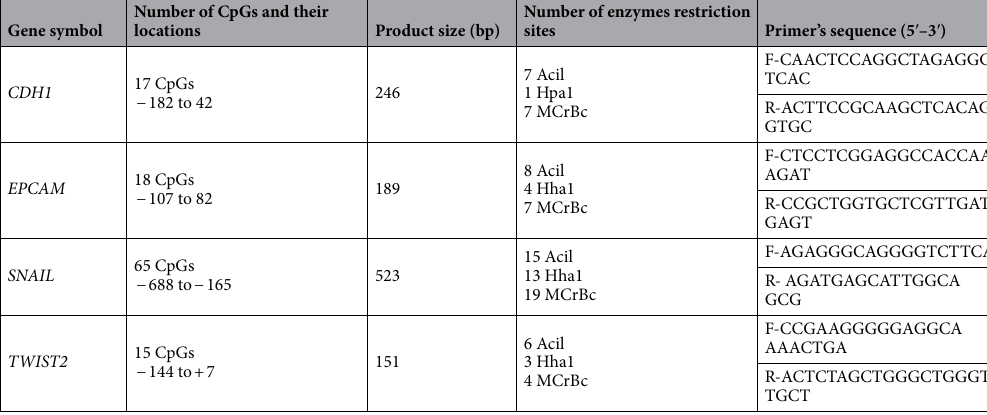
Table 2. Primer sequences used for methylation study using methylscreen